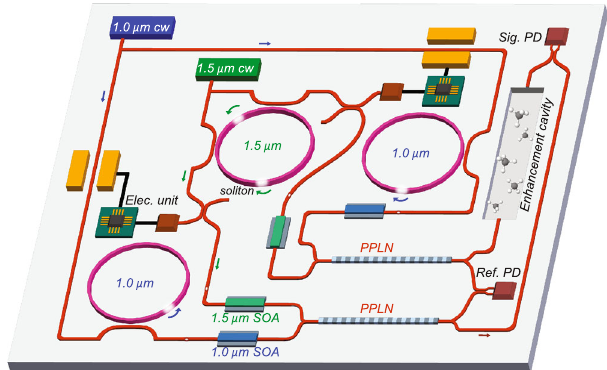
Fig. 4 A conceptualization of a monolithically integrated mid-IR DCS sensor. Two 1.0 μ m solitons phase-locked to the 1.5 μ m CP solitons are used for iDFG in on-chip PPLN waveguides. SOA: semiconductor optical ampli fi